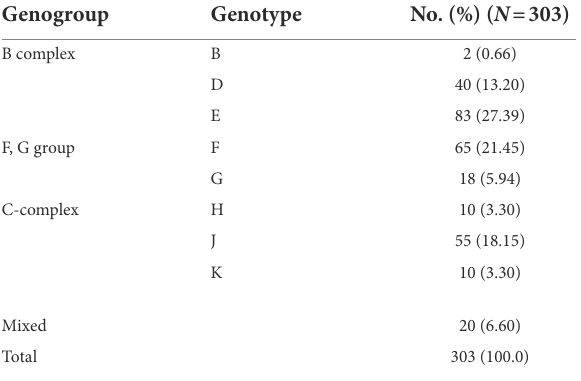
TABLE 1 Distribution of C. trachomatis genotypes in 303 C. trachomatis positive subjects according to ompA sequencing results in Chenzhou, China during 2019 and